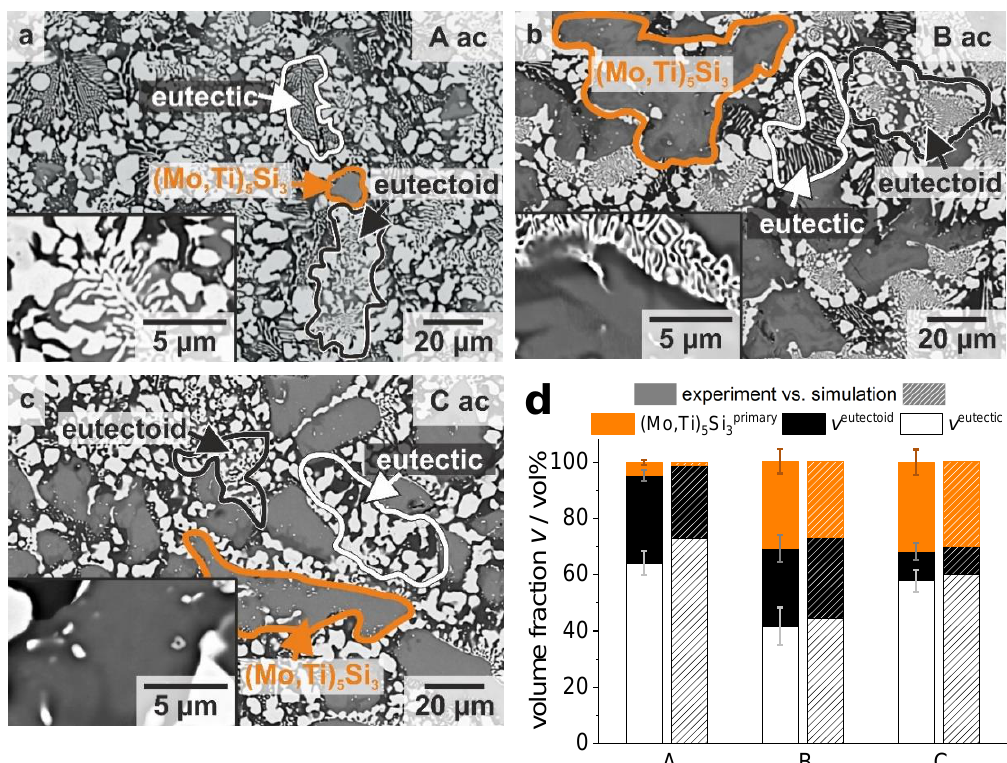
Figure 3. BSE micrographs of the as-cast (ac) microstructures of the alloys A ( a ), B ( b ) and C ( c ). The microstructural constituents are highlighted in orange (globularly-shaped (Mo,Ti) 5 Si 3 ), white (eutectic region) and black (eutectoid region). The transition between eutectic and eutectoid regions is displayed in the insets with higher magnification. In alloy C, a primarily solidified (Mo,Ti) 5 Si 3 region is shown as well in the inset ( c ). Additionally, the experimentally determined volume fractions (solid bars) are compared to the thermodynamic predictions (hatched bars) ( d ).